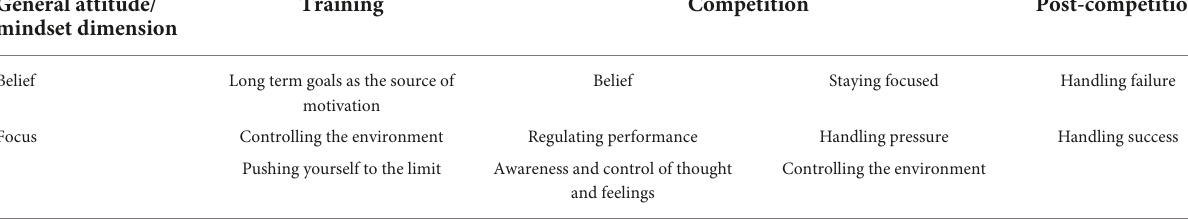
TABLE 1 Attributes of mental toughness (Jones et al., 2007). General attitude/ mindset dimension